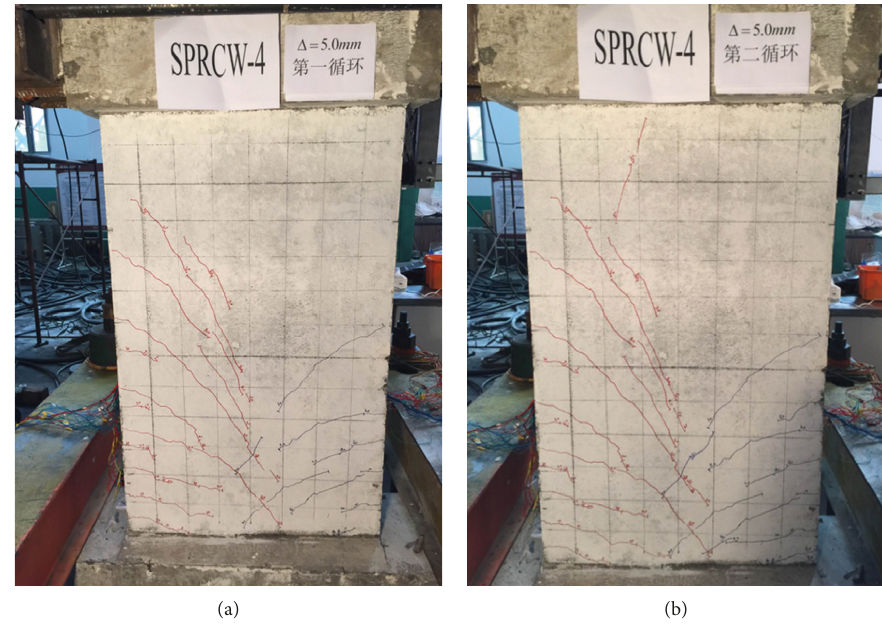
Figure 20: Diagram of cracks in the Δ � 5mm displacement cycle. (a) First cycle. (b) Second